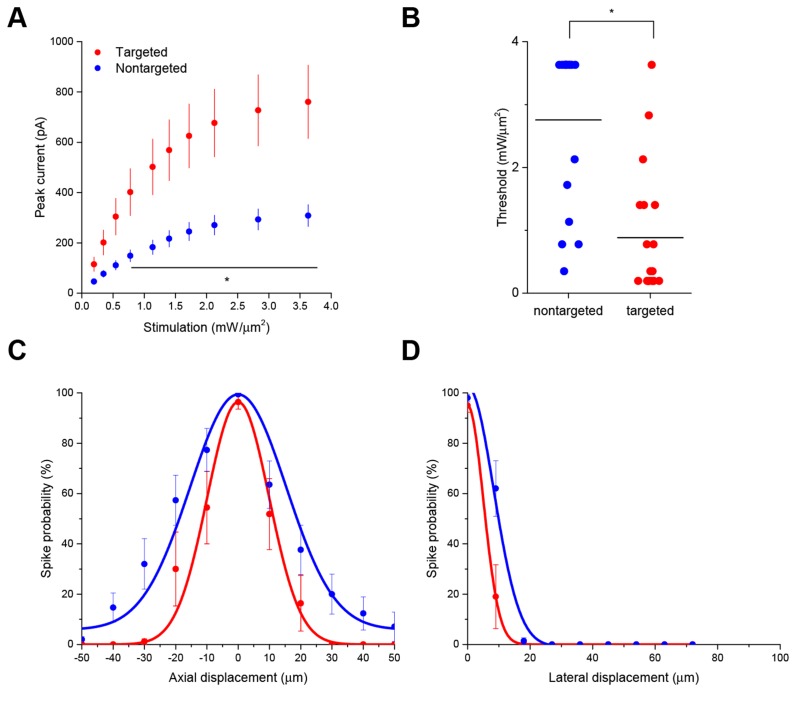
Enhanced sensitivity and resolution with soma-targeted ChR2.(A) Evoked currents in acute slices in response to 150 ms TF stimulation of increasing intensity; targeted ChR2 exhibited significantly greater current (two-way repeated measures ANOVA, p=0.0101 for main effect of targeting, p=0.0056 for targeting × power interaction, *p<0.05 Holm-Bonferroni post hoc test). (B) Minimum TF power required to elicit a single action potential. Each point indicates a single cell; cells expressing targeted ChR2 had a much lower threshold (*p=8.028 × 10–5, Mann-Whitney U Test). (C–D) Probability of evoking spikes per 10 trials in cells expressing targeted (red) or nontargeted (blue) ChR2 when stimulating the soma and at laterally and axially displaced locations.